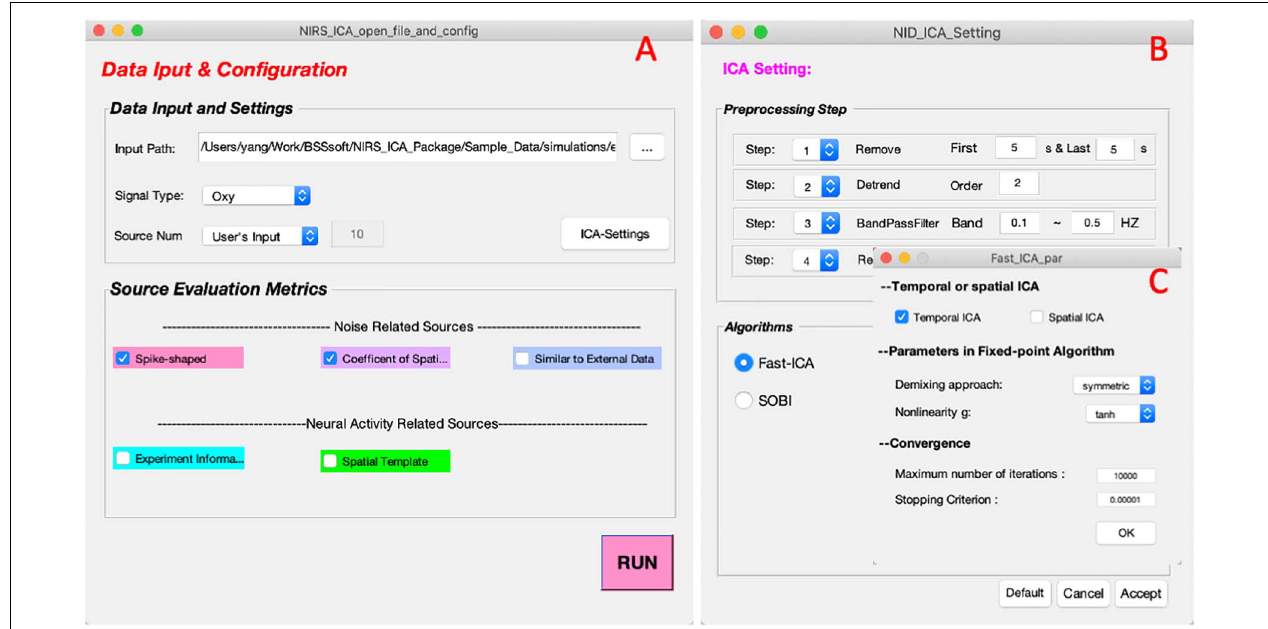
FIGURE 2 | The interfaces of input and configuration of ICA processing. (A) The interface of data input and configuration. (B) The interfaces of ICA settings when users click the button of ICA-Settings in (A) . (C) The interface of setting parameters of